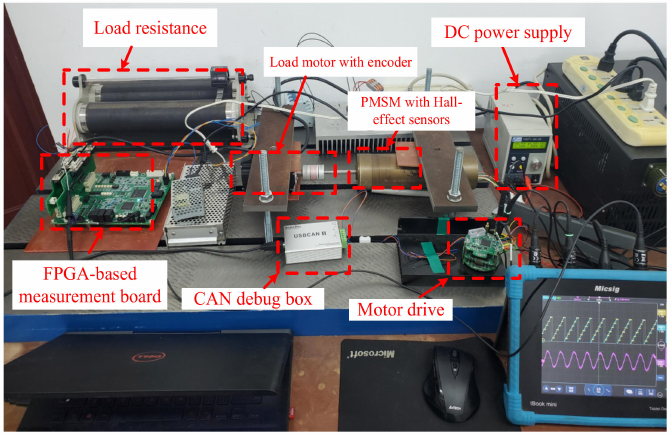
Figure 12. The PMSM drive experimental